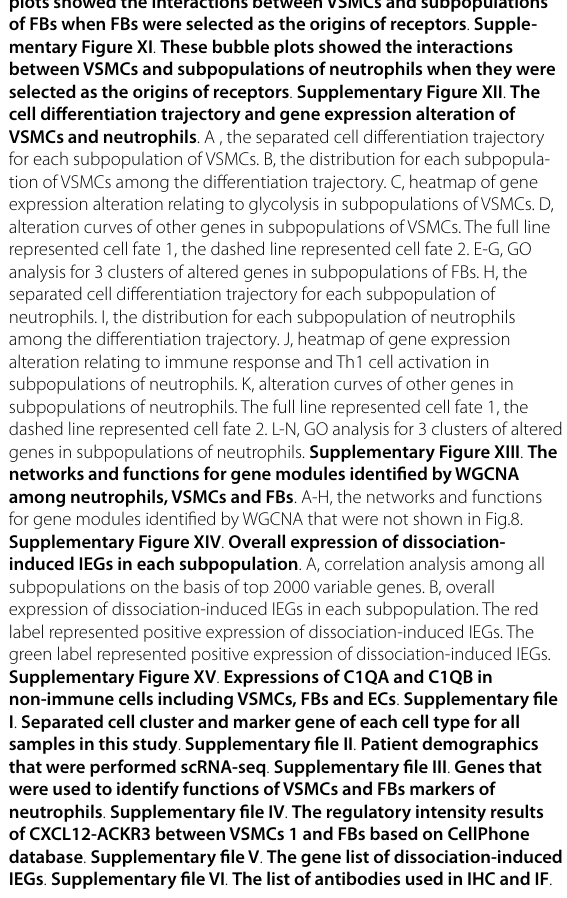
plots showed the interactions between VSMCs and subpopulations of FBs when FBs were selected as the origins of receptors . Supple‑ mentary Figure XI . These bubble plots showed the interactions between VSMCs and subpopulations of neutrophils when they were selected as the origins of receptors . Supplementary Figure XII . The cell differentiation trajectory and gene expression alteration of VSMCs and neutrophils . A , the separated cell differentiation trajectory for each subpopulation of VSMCs. B, the distribution for each subpopula‑ tion of VSMCs among the differentiation trajectory. C, heatmap of gene expression alteration relating to glycolysis in subpopulations of VSMCs. D, alteration curves of other genes in subpopulations of VSMCs. The full line represented cell fate 1, the dashed line represented cell fate 2. E‑G, GO analysis for 3 clusters of altered genes in subpopulations of FBs. H, the separated cell differentiation trajectory for each subpopulation of neutrophils. I, the distribution for each subpopulation of neutrophils among the differentiation trajectory. J, heatmap of gene expression alteration relating to immune response and Th1 cell activation in subpopulations of neutrophils. K, alteration curves of other genes in subpopulations of neutrophils. The full line represented cell fate 1, the dashed line represented cell fate 2. L‑N, GO analysis for 3 clusters of altered genes in subpopulations of neutrophils. Supplementary Figure XIII . The networks and functions for gene modules identified by WGCNA among neutrophils, VSMCs and FBs . A‑H, the networks and functions for gene modules identified by WGCNA that were not shown in Fig.8. Supplementary Figure XIV . Overall expression of dissociation‑ induced IEGs in each subpopulation . A, correlation analysis among all subpopulations on the basis of top 2000 variable genes. B, overall expression of dissociation‑induced IEGs in each subpopulation. The red label represented positive expression of dissociation‑induced IEGs. The green label represented positive expression of dissociation‑induced IEGs. Supplementary Figure XV . Expressions of C1QA and C1QB in non‑immune cells including VSMCs, FBs and ECs . Supplementary file I . Separated cell cluster and marker gene of each cell type for all samples in this study . Supplementary file II . Patient demographics that were performed scRNA‑seq . Supplementary file III . Genes that were used to identify functions of VSMCs and FBs markers of neutrophils . Supplementary file IV . The regulatory intensity results of CXCL12‑ACKR3 between VSMCs 1 and FBs based on